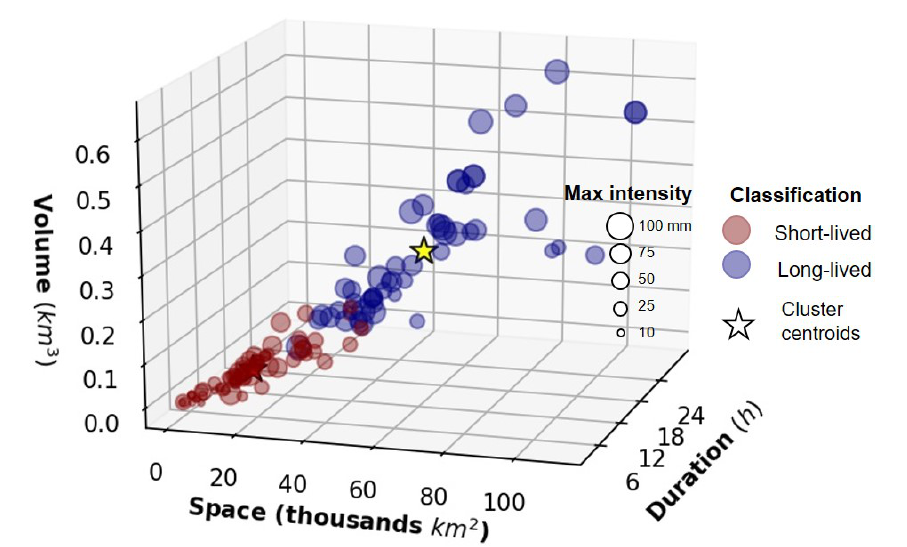
Figure 5. Short- and long-lived cluster analysis classification for observed events during monsoon season